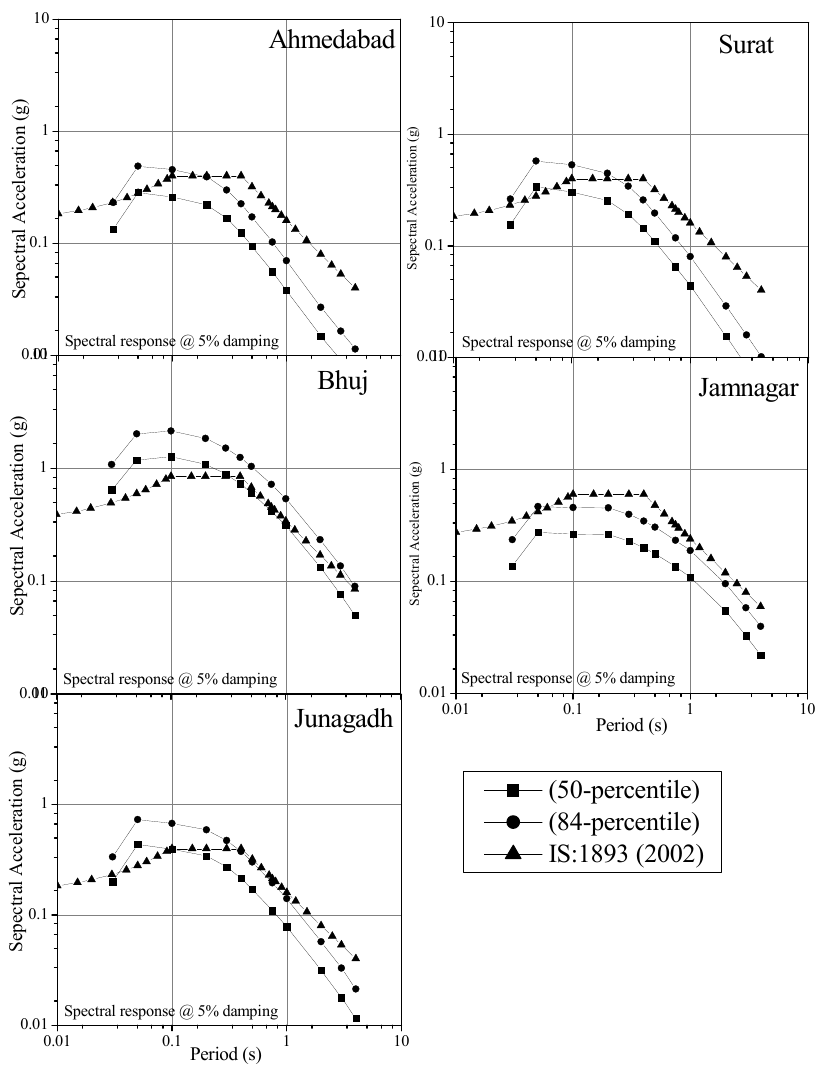
Fig. 13. 50th percentile deterministic hazard spectra for five cities in Gujarat, India. The ground accelerations are plotted in unit of 5% damped acceleration response spectrum as a function of period and its comparison with IS:1893-Part I (2002) specified spectra for seismic design of structures at particular site location.